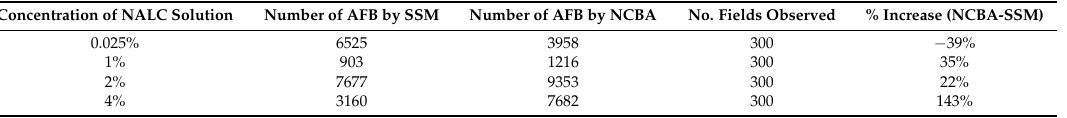
Table 1. Optimization of N-acetyl- L -cysteine (NALC) treatment. Concentration of NALC Solution